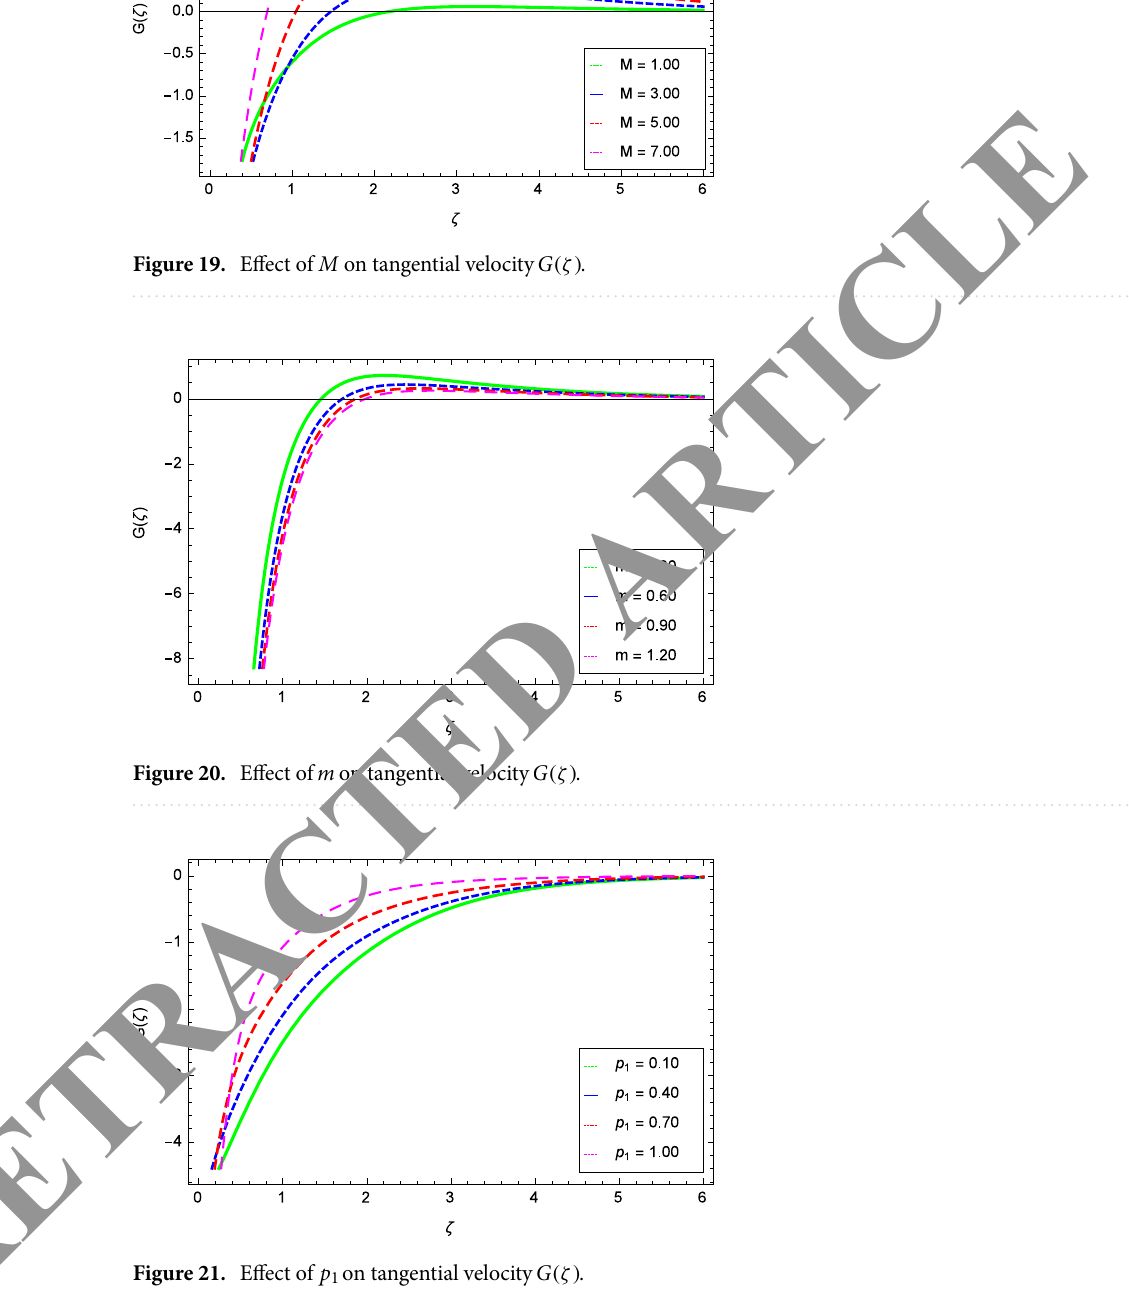
Figure 21. Effect of p 1 on tangential velocity G (ζ) .